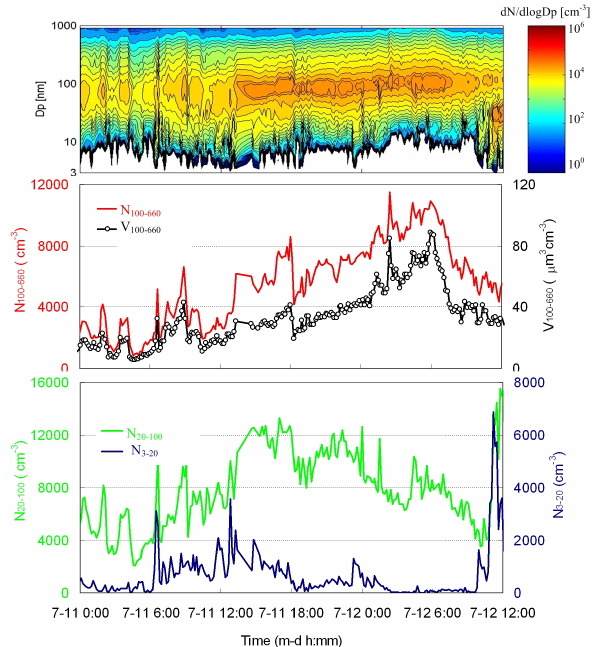
Fig. 2. Variations of particle number size distributions, number con- centrations, and volume concentrations at BG from 00:00LT, 11 July to 12:00LT, 12 July.